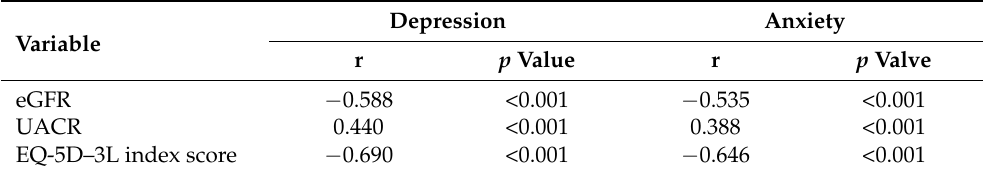
Table 5. The correlation analysis between the clinical indicators and depression and anxiety in the DKD DKD patients.